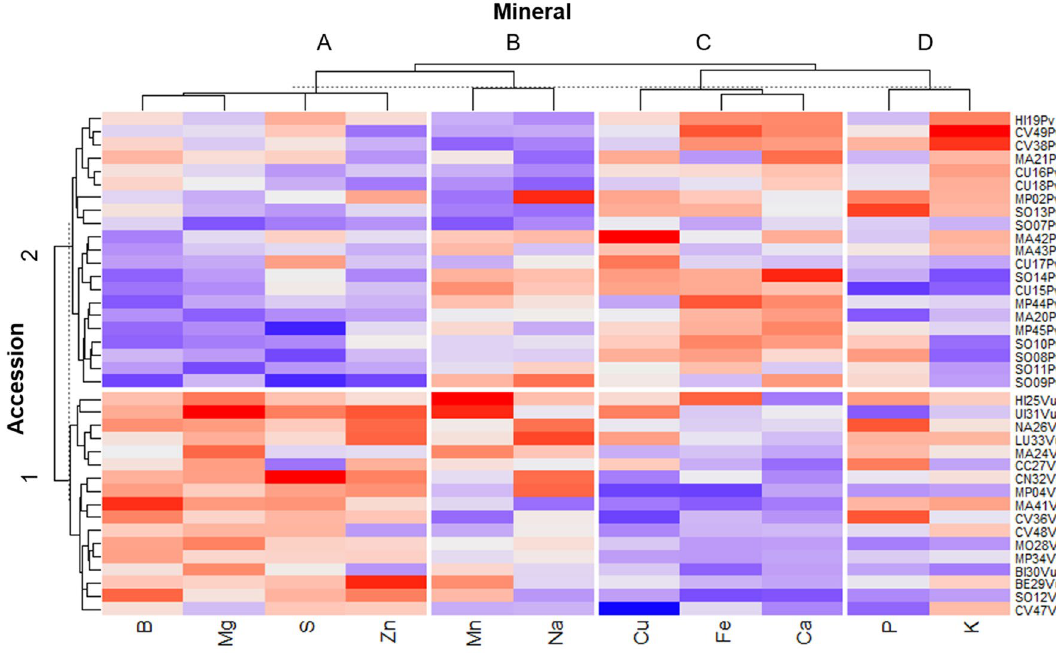
Figure 4. Heatmap of the 21 Phaseolus vulgaris and 17 Vigna unguiculata accessions obtained from the chemical characterization data for the content of 11 minerals. Red and blue boxes indicate high values and low values